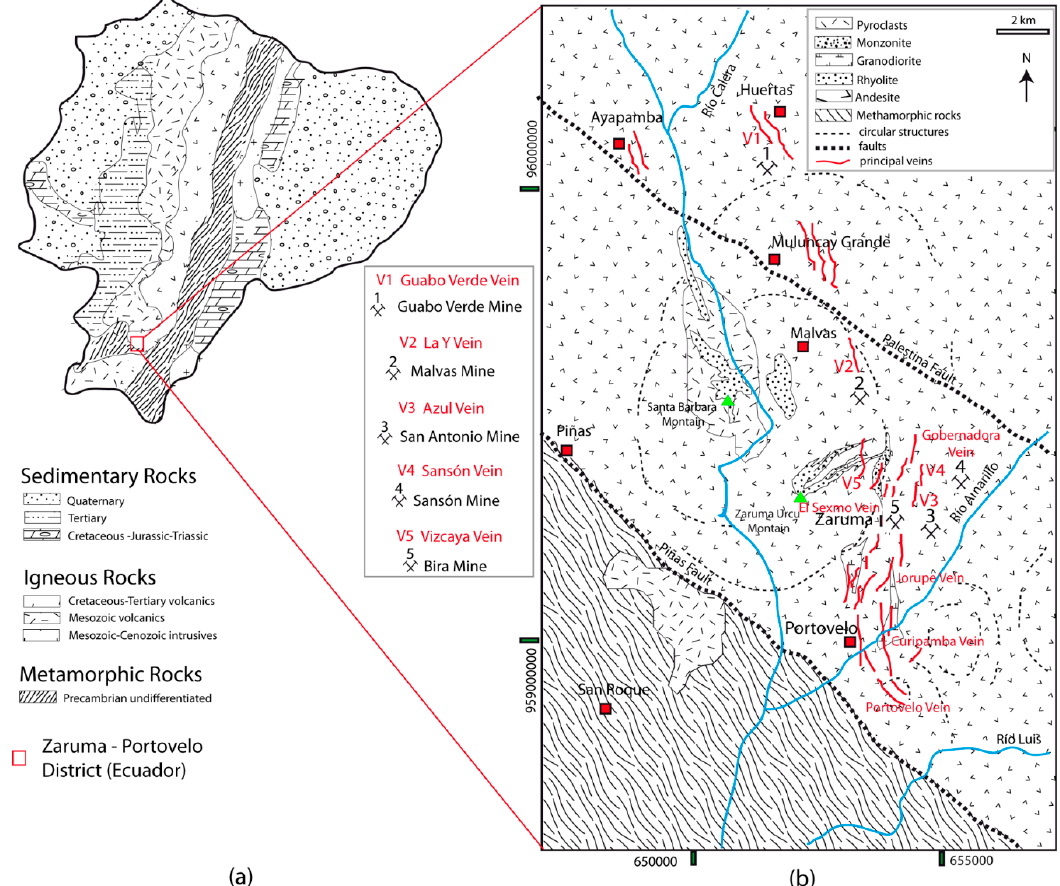
Figure 1. ( a ) Simplified geological map of Ecuador and location of selected area; and ( b ) geological maps of Zaruma-Portovelo gold field with basic geology (volcanic and intrusive rocks), principal structures and more important veins. Modified from [38] with data from [39–42].